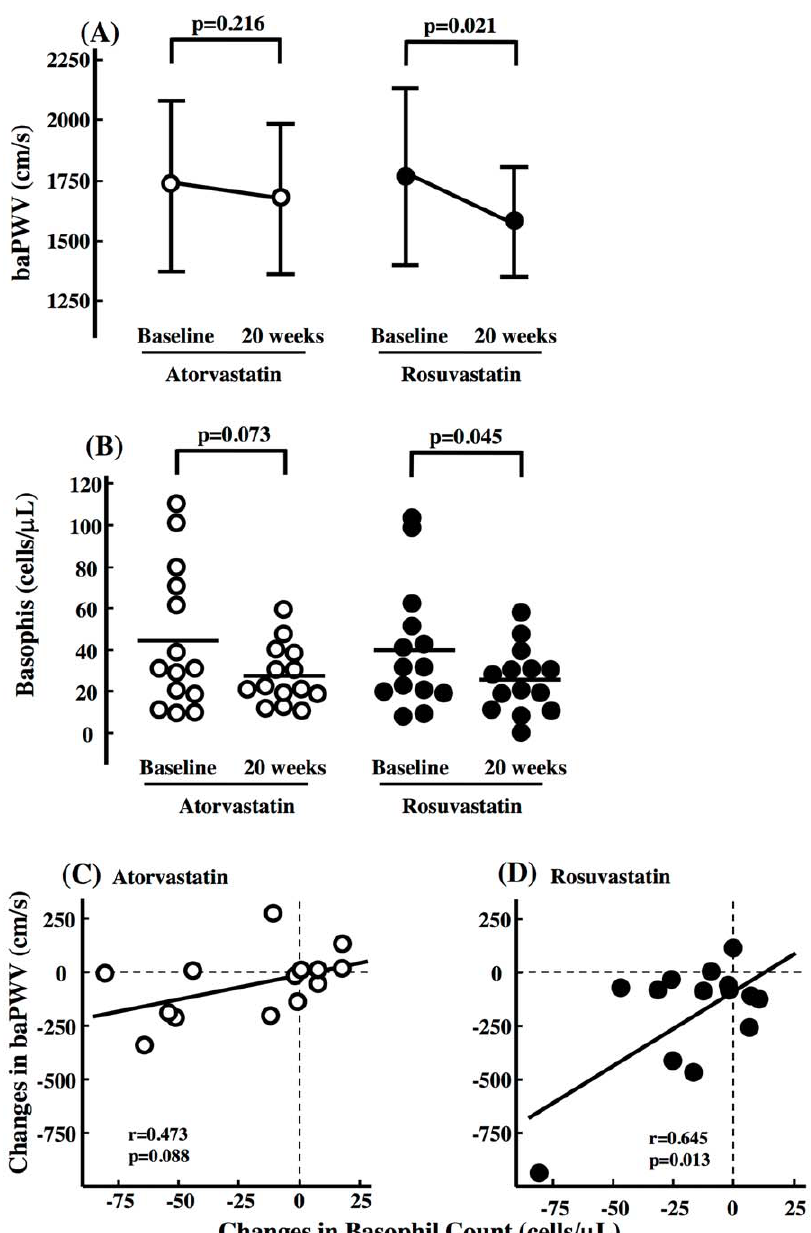
Figure 4. Effect of Atorvastatin or Rosuvastatin Combined with Exercise on Arterial Wall Stiffness and Plasma Basophil. Comparison of changes in (A) brachial and ankle pulse wave velocity (baPWV) and (B) basophil count, between atorvastatin (n=14) and rosuvastatin (n=14) groups. Data are mean 6 SD. Correlation between changes in baPWV and basophil count in (C) atorvastatin and (D) rosuvastatin groups.